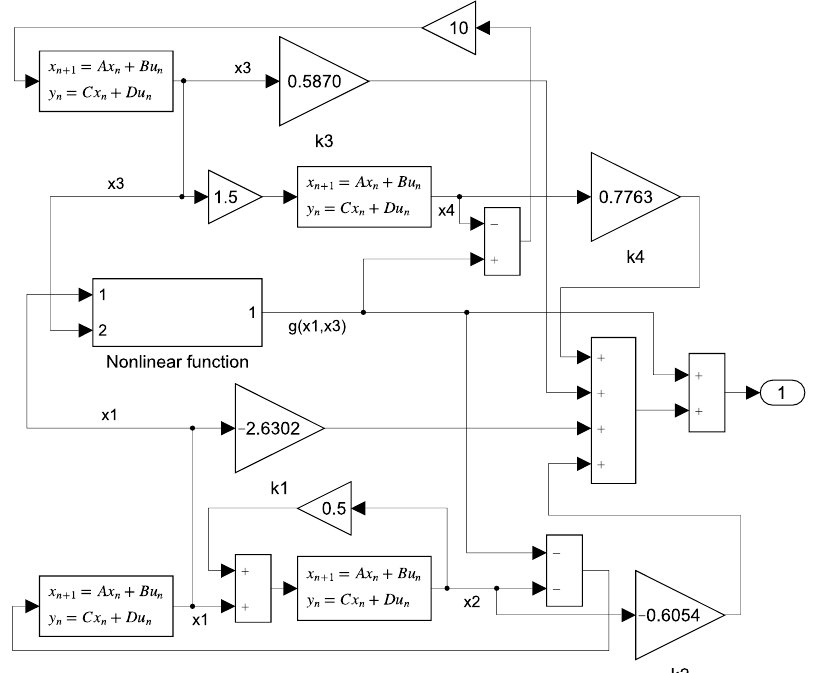
Figure 7. Implementation of chaotic generator in the ACSK